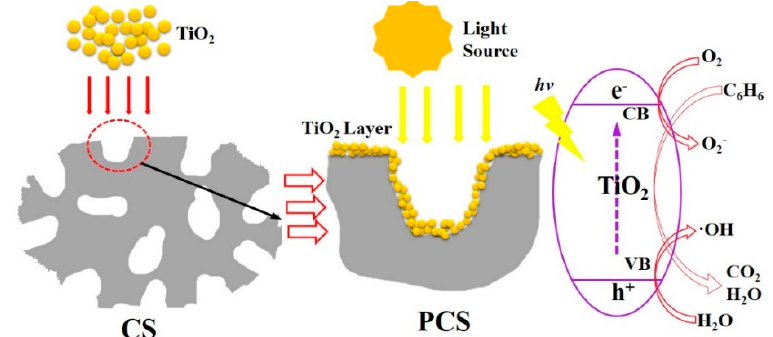
Figure 7. Preparation and catalytic mechanism of PCS. Appl. Sci. 2017 , 7 , 828